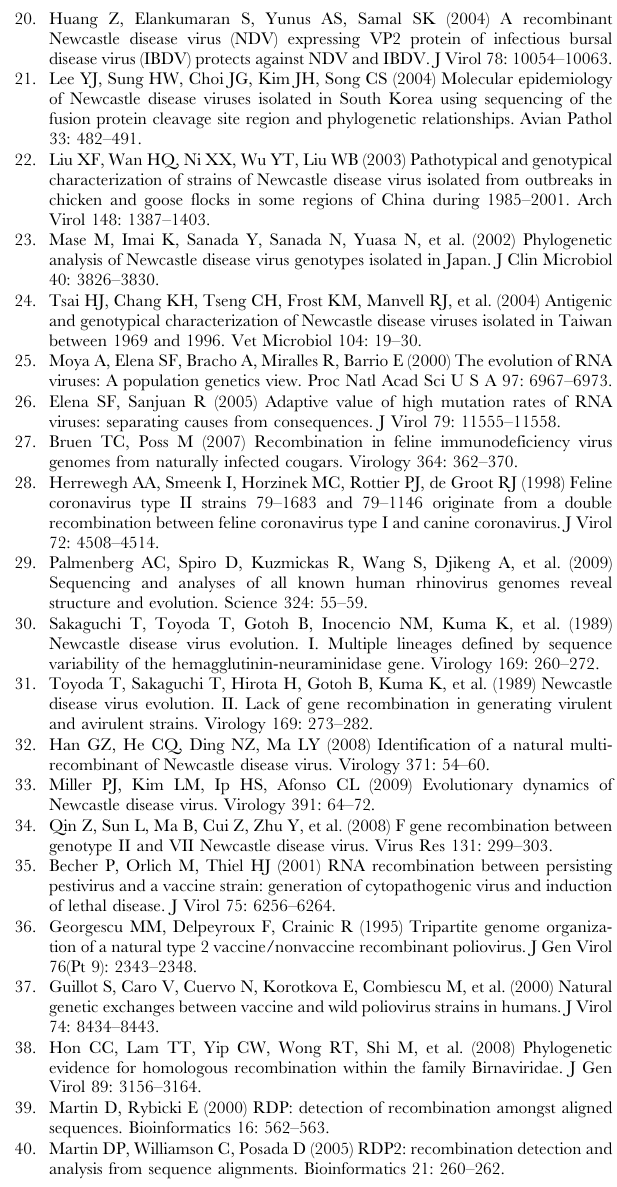
Table S4 The evolutionary rates and time to the most recent common ancestor (TMRCA) of each gene and concatenated